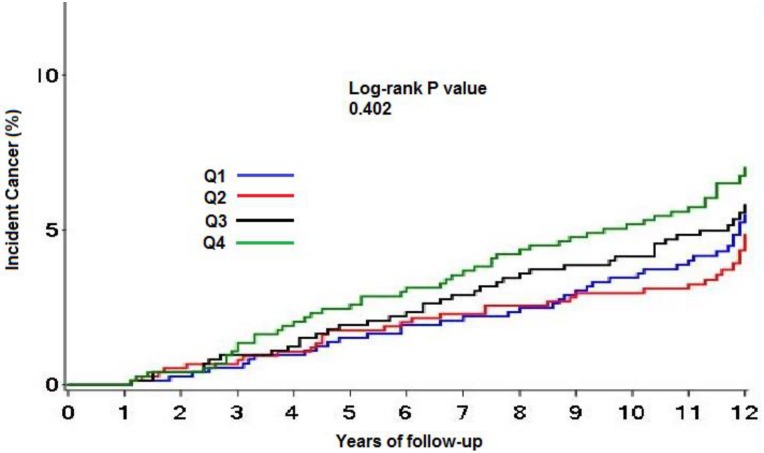
Kaplan Meier curve of time to cancer by sex- specific leptin quartiles.Vertical axes show the percentage of subjects developing cancer in each quartile, horizontal axes represent years of follow- up. Median interval to cancer diagnosis was 8.1 years. (Q1 refers to quartile 1, Q2 to quartile 2, etc.).